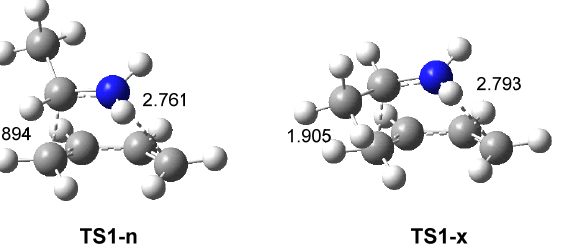
Figure 4. ω B97XD/6-311G(d,p) geometries of TS1-n and TS1-x . The C–C and C–N distances are given in